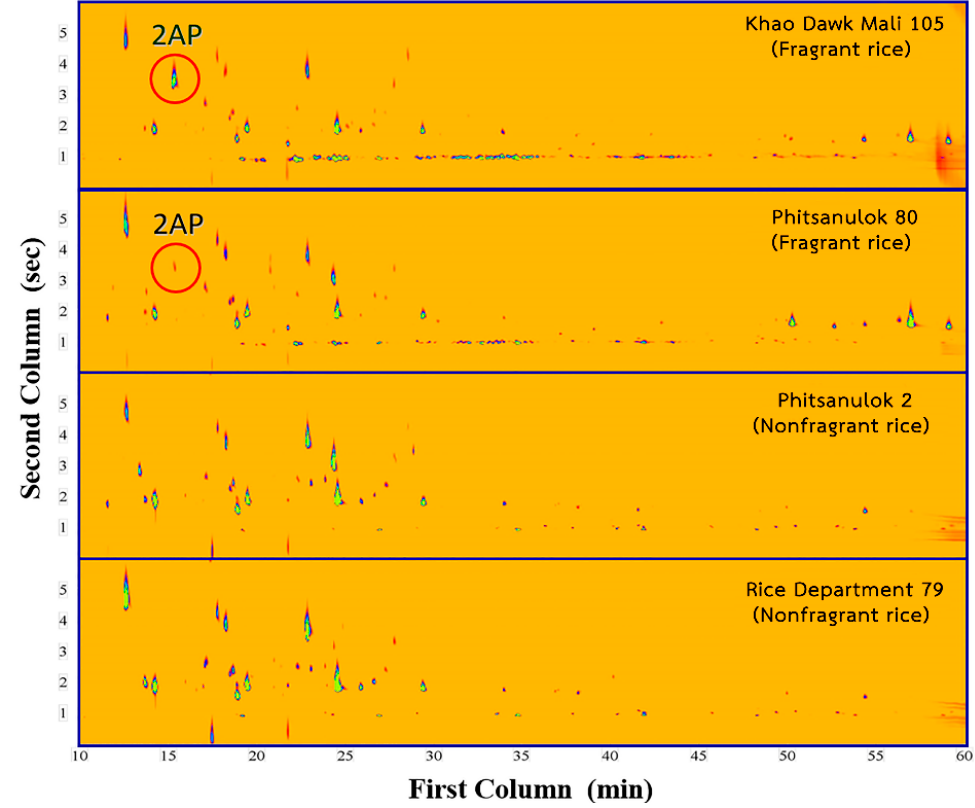
Figure 4. GC×GC–MS contour plots of extracts from fragrant and nonfragrant rice samples. Figure 4. GC × GC–MS contour plots of extracts from fragrant and nonfragrant rice